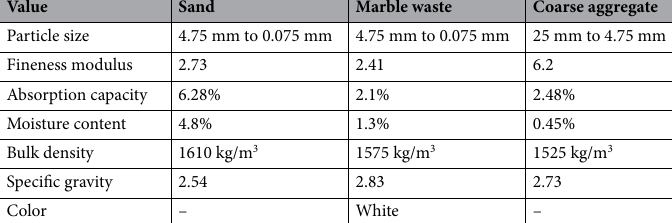
Table 3. Physical properties of fine aggregate, marble waste and coarse